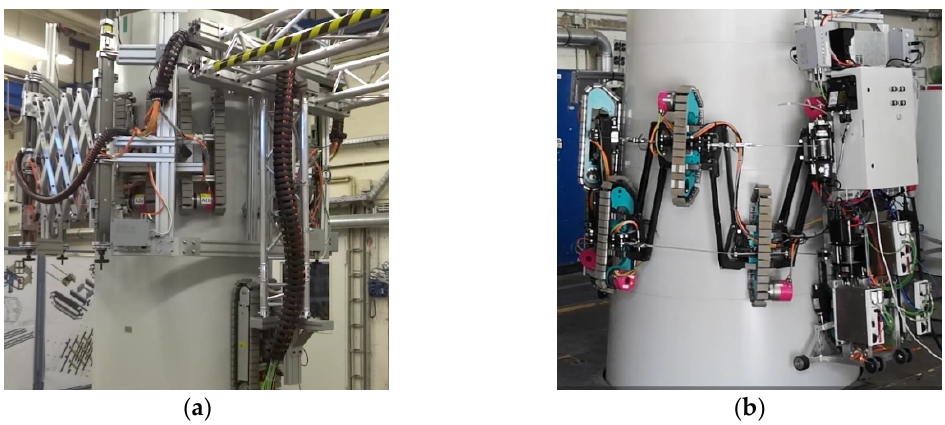
Figure 4 . Climbing ring robot (CRR) demonstrator 2016 ( a ); CRR demonstrator 2018 ( b ). Both are scaled by a factor of 1:3 regarding a 2.5 MW wind turbine.